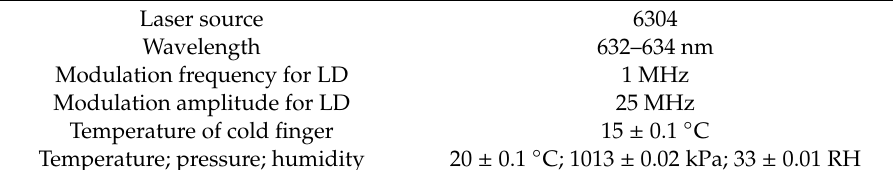
Table 1. Experimental conditions of the locking frequency of the laser diode (LD).